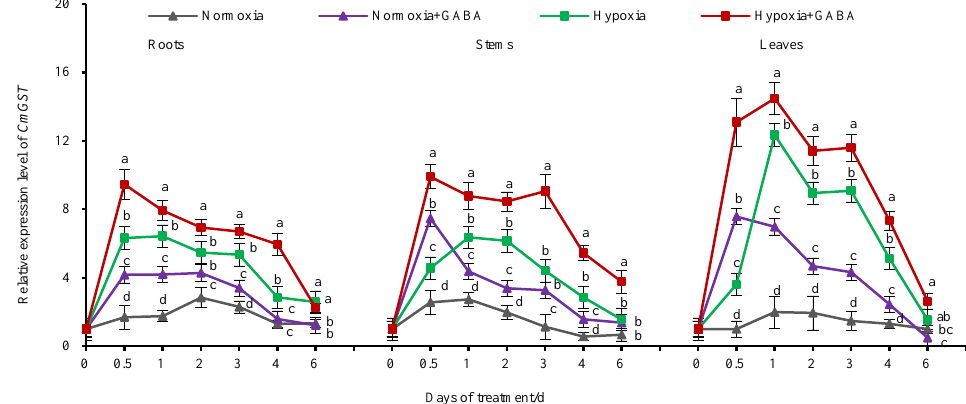
Figure 3. Multiple alignments of the amino acid sequences of CmGST and those of other species. Conserved residues in all plant TCHQD GSTs are indicated below. MELO3C010516.2.1 ; C. melo GST TCHQD, AtTCHQD1 ; Arabidopsis thaliana GST TCHQD (NP_177853.1), MdTCHQD1 ; Malus pumila GST TCHQD (MD15G1133600), SlTCHQD ; Lycopersicon esculentum Miller GST TCHQD (Solyc04g057890.2), OsTCHQD1 ; Oryza sativa GST TCHQD (LOC_Os04g35560.1), BrTCHQD ; Brassica rapa GST TCHQD (Brara.G03507.1.p), TaTCHQD ; Triticum aestivum GST TCHQD (Traes_2BL_32FE5AEF9.2), CsTCHQD ; C. sativus GST TCHQD (Cucsa.018410.1) are included in the alignment.